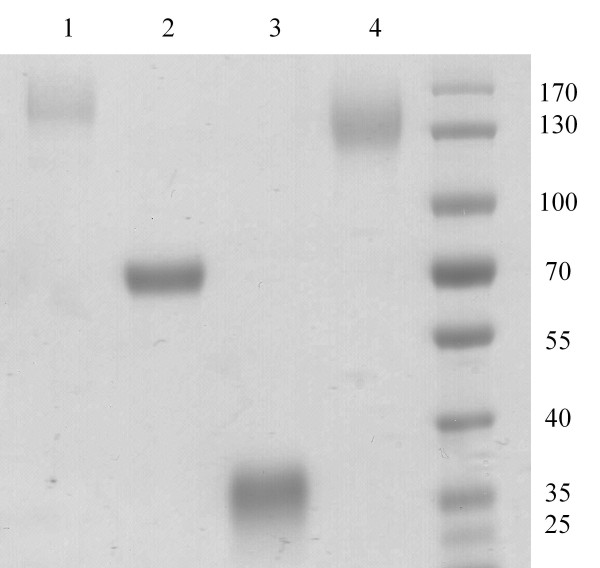
SDS-PAGE analysis of PpCel45A and its derived constructs. 10 μg of each purified recombinant protein was loaded onto a 12% Tris glycine SDS-PAGE and proteins were stained with Coomassie blue. PpCel45A (lane 1), PpCBM15:GH (lane 2), PpGH (lane 3) and PpCBM11-5 (lane 4). Molecular masses (kDa) of marker proteins are shown on the right.